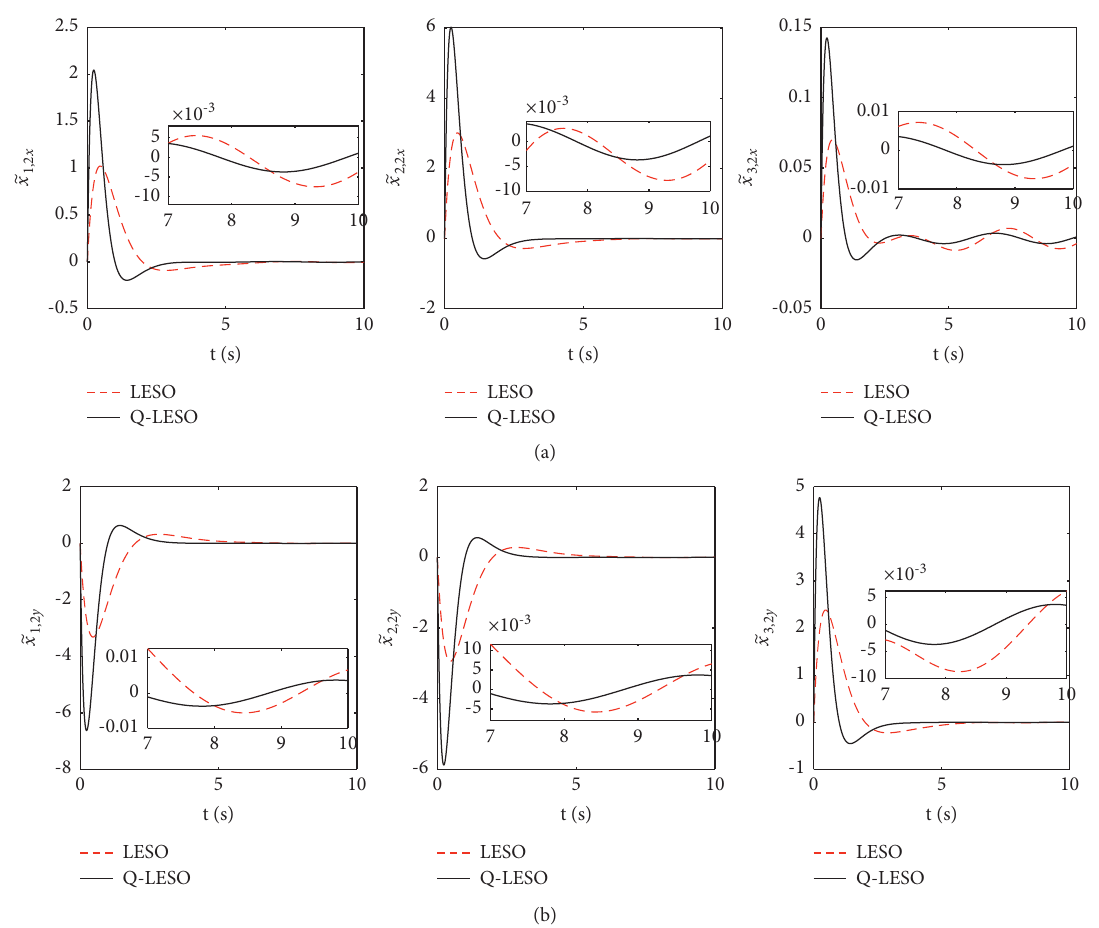
Figure 11: The velocity estimation error 􏽥 x i, 2 in Case B(a) The velocity estimation error of the x -direction of the i th agent i velocity estimation error of the y -direction of the i th agent i � 1, 2,